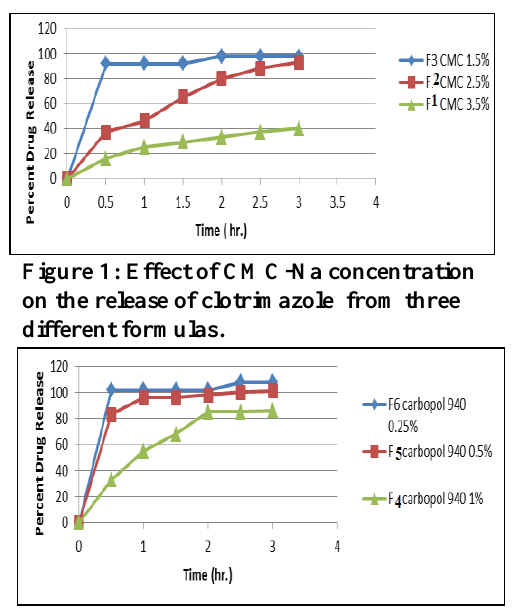
Figure 2: Effect of different carbopol 940 concentration on the release of clotrimazole from three different formulas.